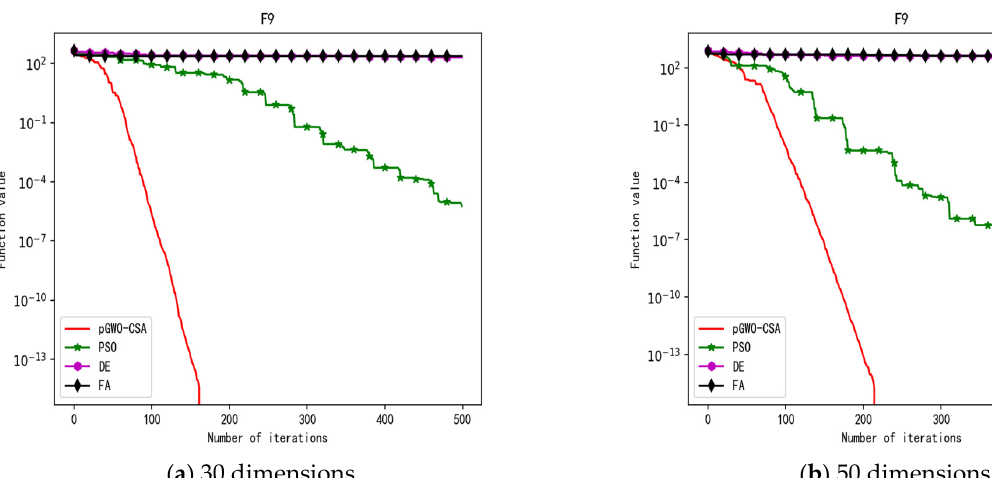
Figure 13. Convergence curve of test function F9.